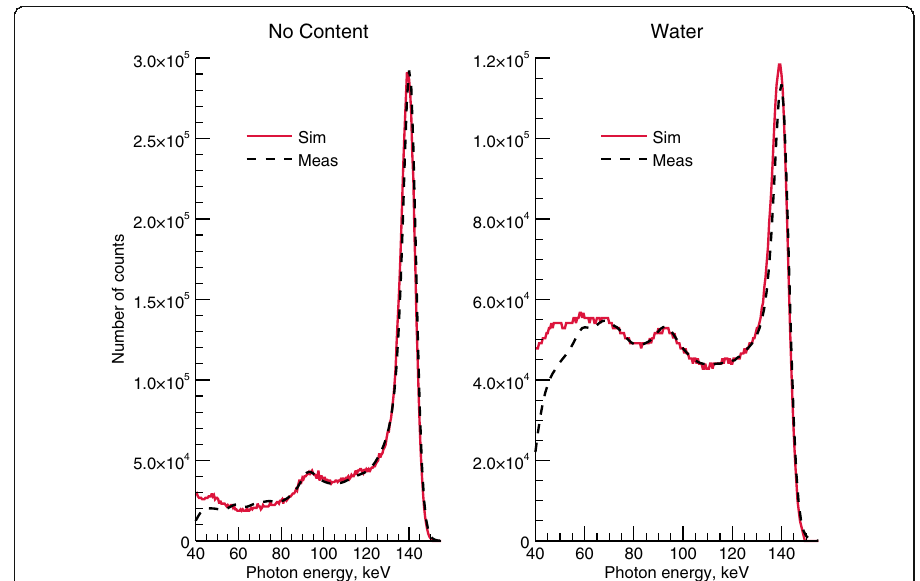
Fig. 11 Simulated (solid) and measured (dashed) spectra showing registered counts for different energies. The simulated and measured curves agree well regardless of torso content, proving that both the CZT model and pinhole routine employed in SIMIND are